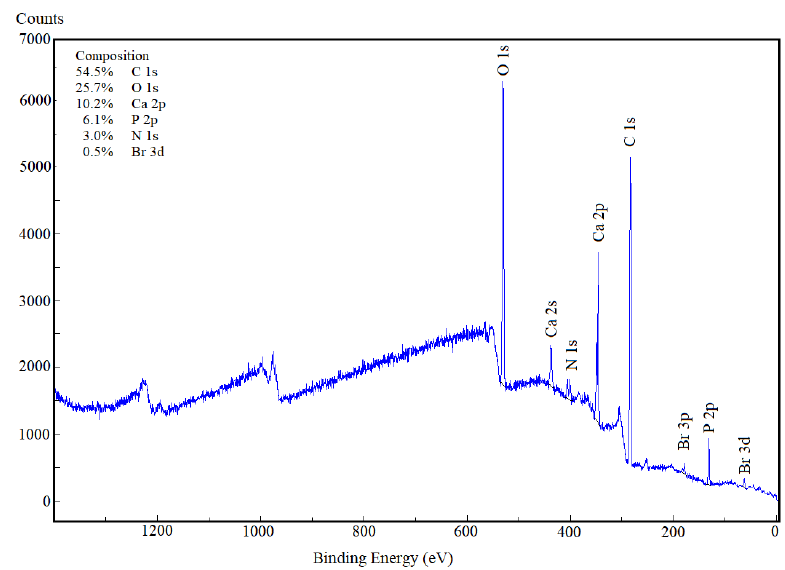
Figure 5. XPS general spectrum of N and Br co-doped HAp composite thin film.